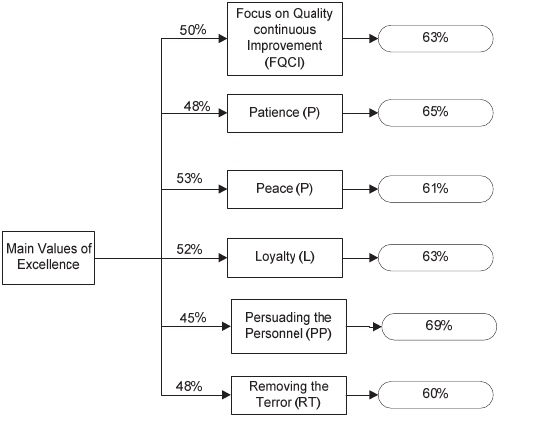
Fig. 9. Factor Analysis Model of hidden variable named Fig. 8. Factor Analysis Model of hidden variable Global common Values (The fourth indicator of Quality named Main Values of Excellence (The third Improvement in Higher Education) indicator of Quality Improvement in Higher Education)